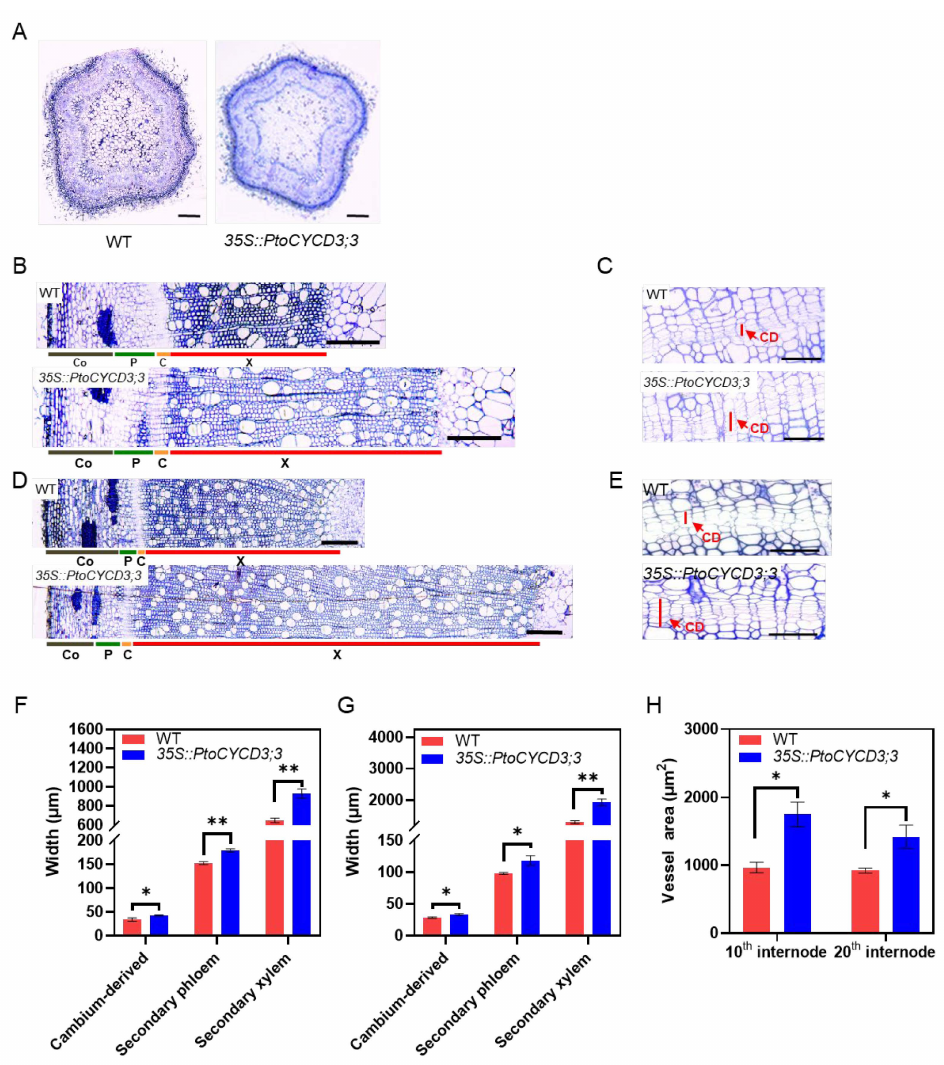
Figure 5. Effects of overexpressing PtoCYCD3;3 on Populus stem development. ( A , B , D ) Cross-sections of the second, 10th, 20th internode in stems of wild-type (WT) and 35S::PtoCYCD3;3 plants. ( C , E ) Cambial-derived tissue of the 10th and 20th internode in stems of WT and 35S::PtoCYCD3;3 plants. ( F ) Width of cambial-derived tissue, secondary phloem, and secondary xylem of the 10th internode in stems of WT and 35S::PtoCYCD3;3 plants. ( G ) Width of cambial-derived tissue, secondary phloem, and secondary xylem of the 20th internode in stems of WT and 35S::PtoCYCD3;3 plants. ( H ) Vessel area of the 10th and 20th internode in stems of WT and 35S::PtoCYCD3;3 plants. Co: cortex, P: phloem C: cambial, X: xylem, CD: cambial-derived tissue. Significance as determined by independent sample T-test: * p < 0.05, ** p < 0.01. The values are means ± SE, n = 3. Three transgenic lines were used. Bar, 100 µ m ( A ); 200 µ m ( B – E